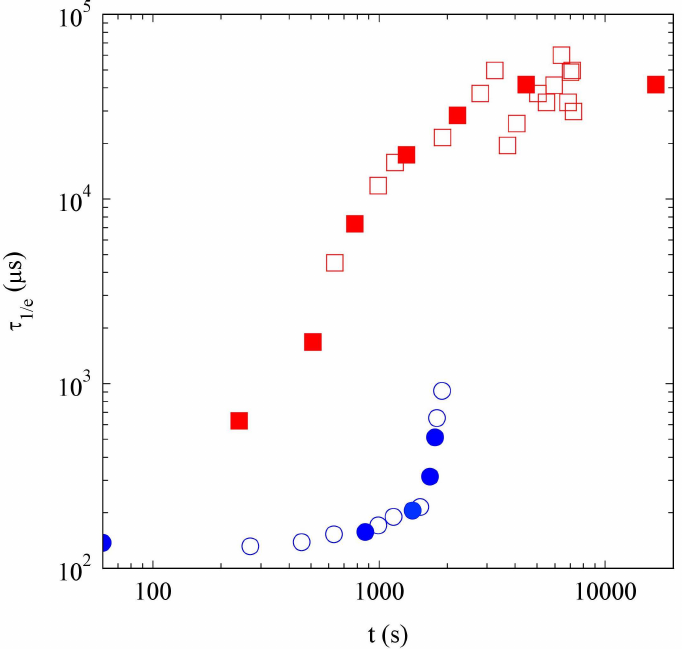
Figure 6. Decay times of the ICFs τ 1/ e as a function of time, for samples H (circles) and L (squares). Full points refer to the ICFs shown in Figure